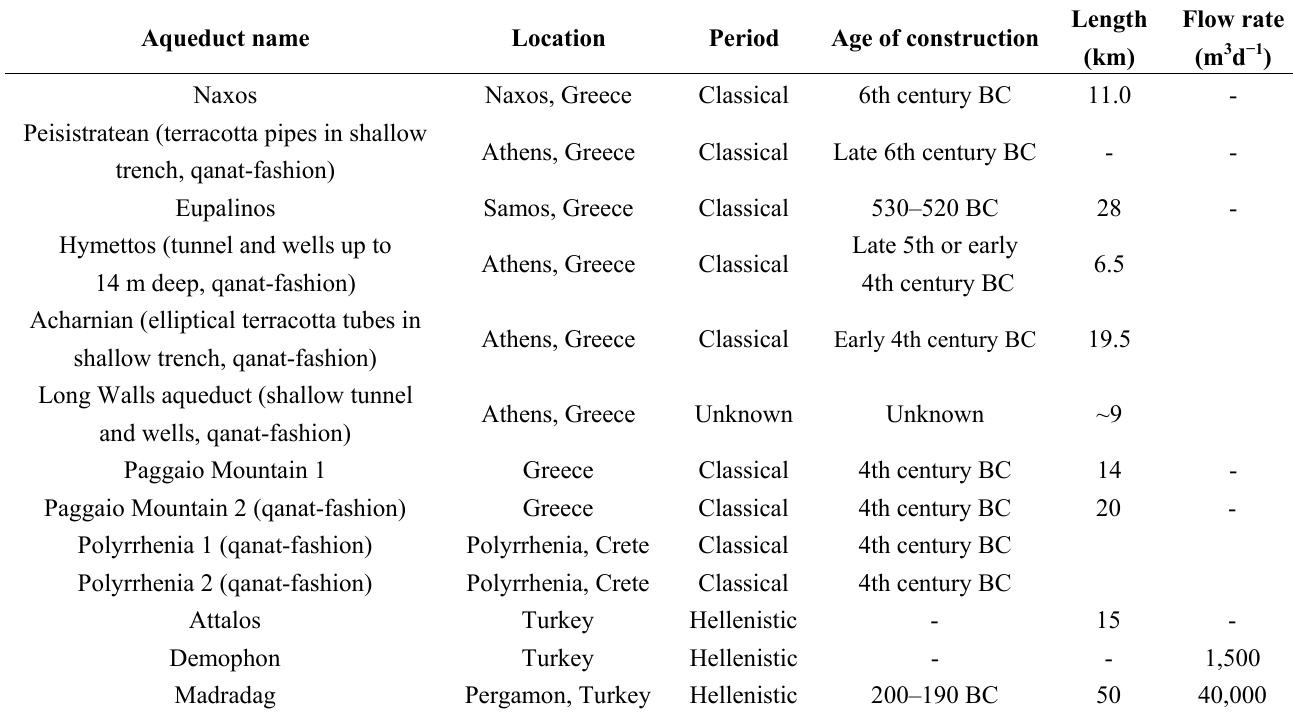
Table 3. Characteristics of Classical and Hellenistic aqueducts (adapted from De Feo et al.